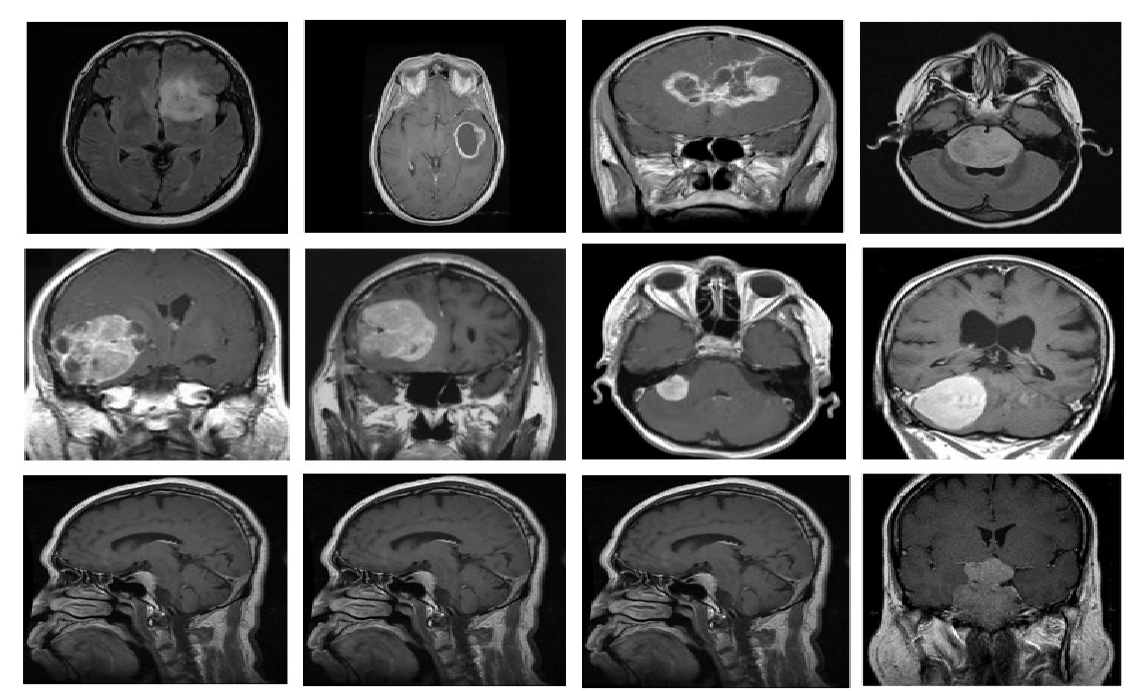
Table 1. Brain tumor classification (MRI) dataset details.